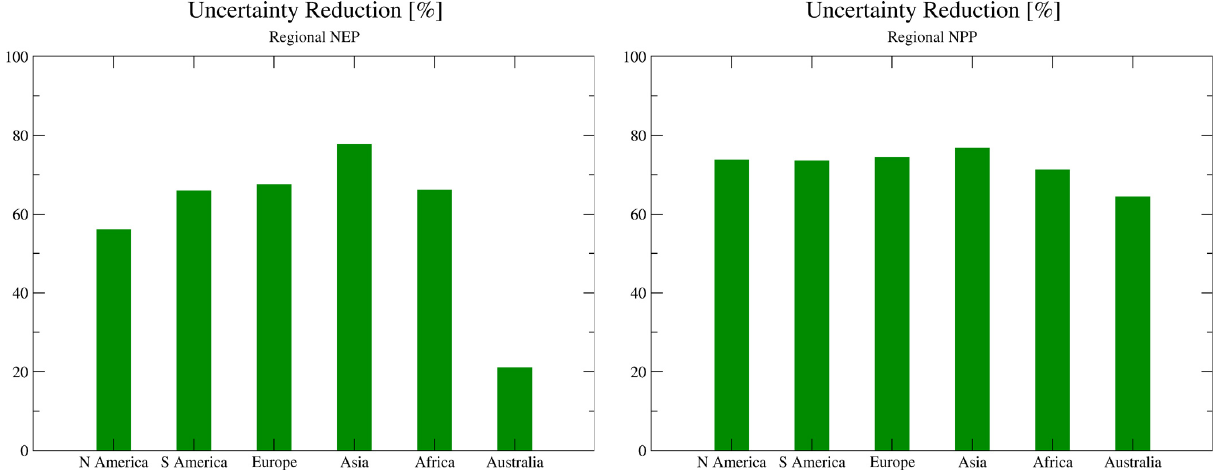
Fig. 6. Uncertainty reduction in simulated NEP (left hand panel) and NPP (right hand panel) over six regions.